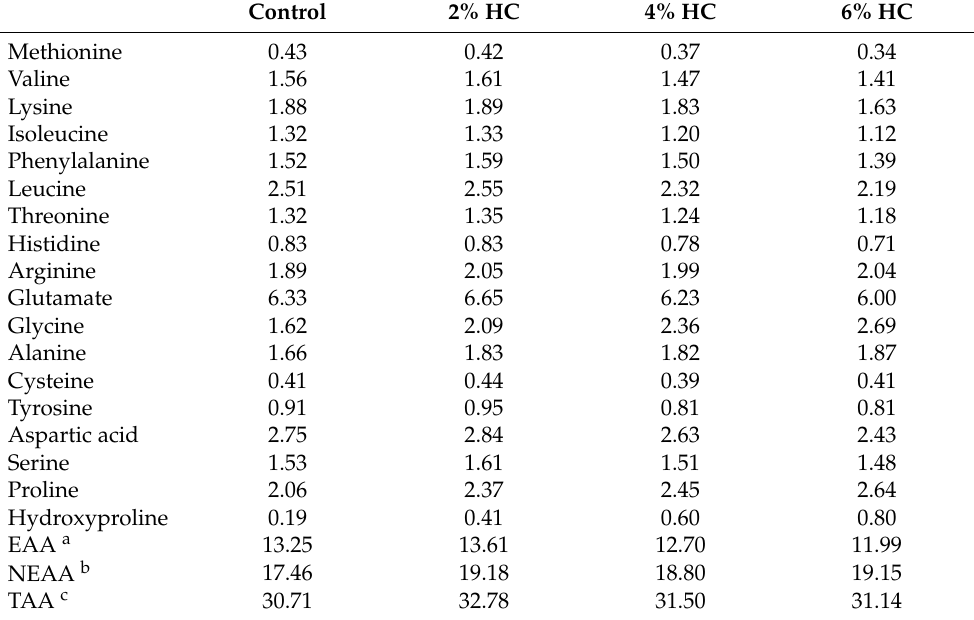
Table 4. Amino acid composition of diets (% dry